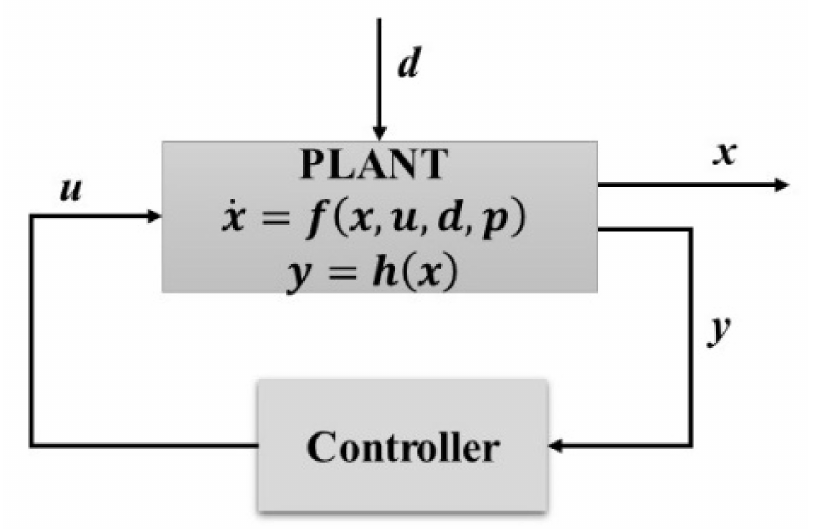
Figure 5. General control